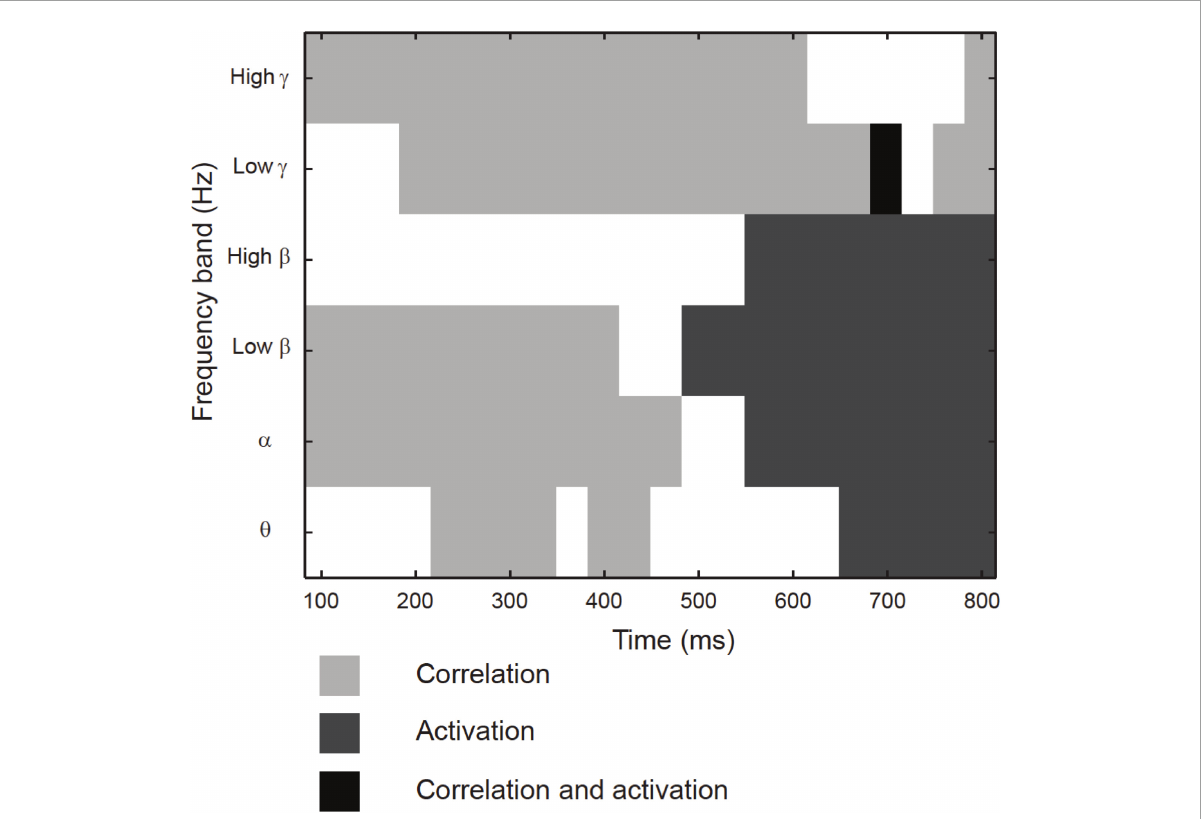
FIGURE6 Temporo-spectral uniqueness and overlap in modulation of rhythmic activity and MEG-fMRI correlation. Timing with respect to picture presentation is plotted on the x -axis, and the different frequency bands on the y-axis. Time-frequency windows that showed differences between the conditions only for MEG band-limited power (light gray), only for MEG-fMRI correlation (dark gray) or both (black). Values averaged across all